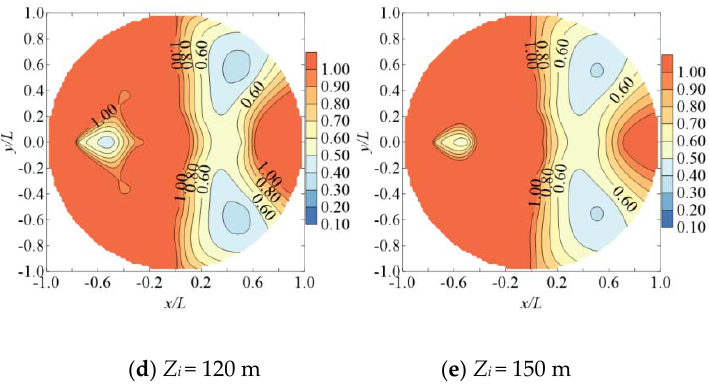
Figure 13. The vertical turbulence intensity at different heights.